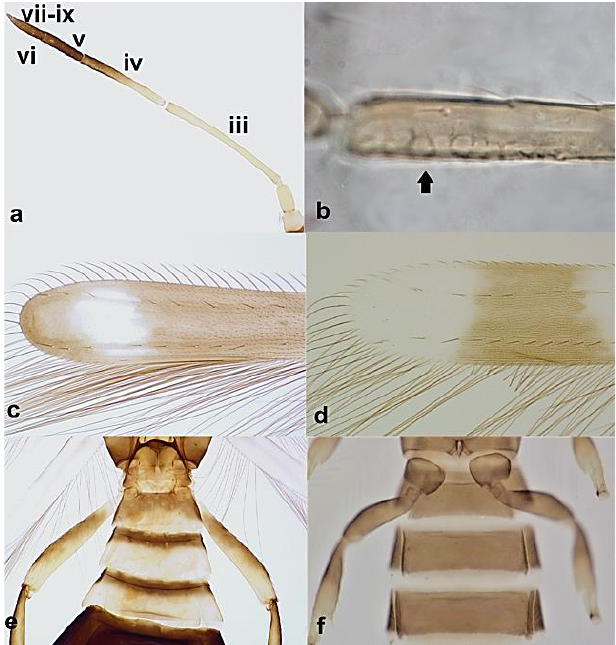
Figure 5. ( a ) antennal segments III–IX; ( b ) sensorium on antennal segment III; fore wing tip ( c , d ): ( c ) with dark band sub-apically; ( d ) with light-coloured sub-apical region; upper abdominal segments ( e , f ): ( e ) being considerably narrower than other segments; ( f ) only slightly narrower than other segments. 5 Antennal segments III and IV with sensoria consisting of one continuous ridge-like structure lined up parallel to length of segment (Figure 6a); fore wings broad, being less than six times as long as broad and with two dark bands (Figure 6c); pronotum postero-marginal setae as long as discal setae ……………….. Aeolothrips Haliday .. 6 Antennal segments III and IV with sensoria consisting of lens-shaped structures lined up parallel to length of segment (Figure 6b); fore wings narrow, being more than six times as long as broad and of a uniformly pale brown hue (Figure 6d); pronotum bearing a pair of postero-marginal setae that are longer than discal setae ……………… ……………………………………………………………………… Rhipidothrips Uzel .. 9